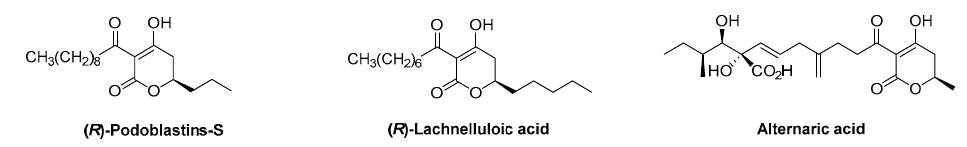
Figure 2. All three 3-acyl-5,6-dihydro-2 H -pyran-2-one natural products.